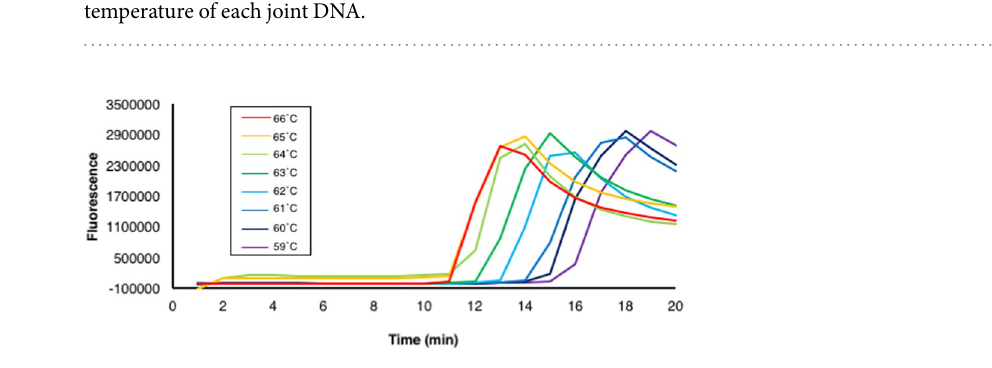
Figure 2. Optimization of LAMP reaction temperature with the designed SIX3 primer sets. LAMP was performed with DNA of Fol race 1 at different temperatures from 59 to 66 °C for 20 min. Similar results were obtained in two independent